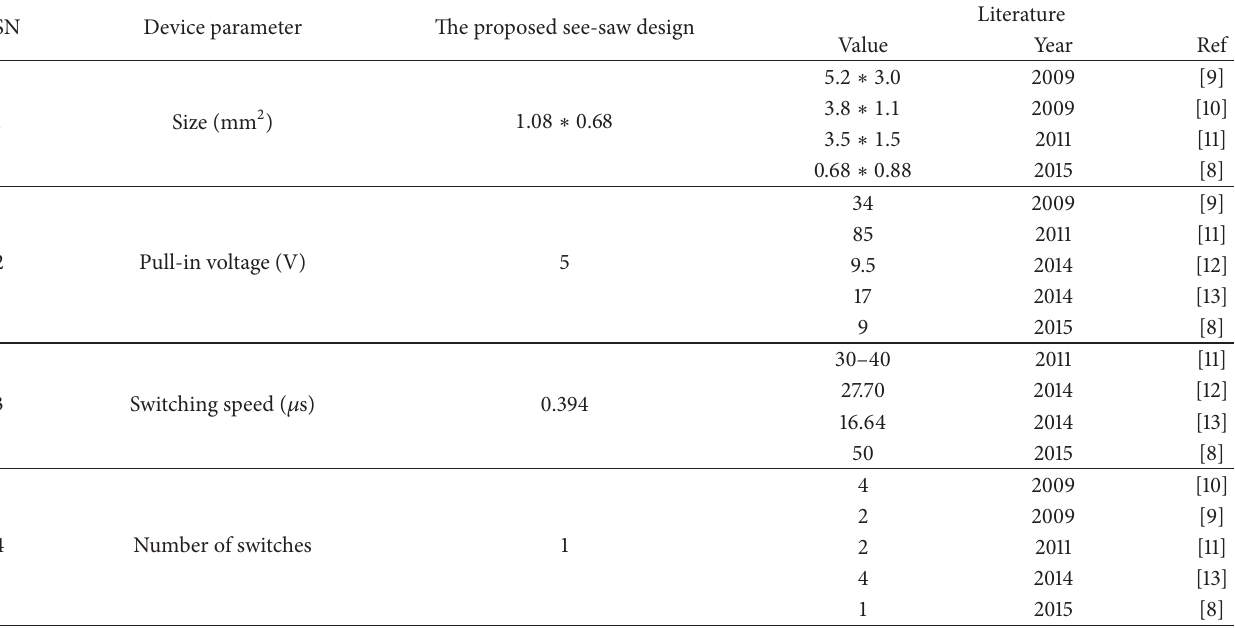
Table 2: Literature survey of size, pull-in voltage, switching time, and number of switches used in the SPDT switch. SN Device parameter The proposed see-saw